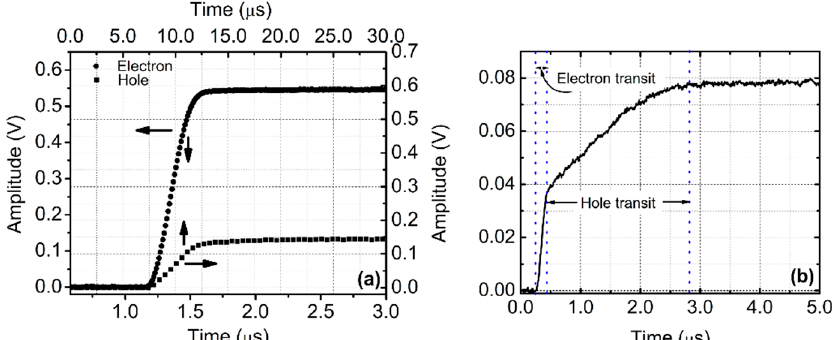
Figure 15. ( a ) Pulse shapes obtained for electrons and hole transits across a VBM grown Cd 0.9 Zn 0.1 Te 0.97 Se 0.03 planar detector using the 241 Am alpha particle source. ( b ) Pulse shape for composite electron-hole transit when the detector was exposed to the 137 Cs gamma-ray (662 keV) source (Adapted with permission from ref. [21]. Copyright 2021, IEEE).